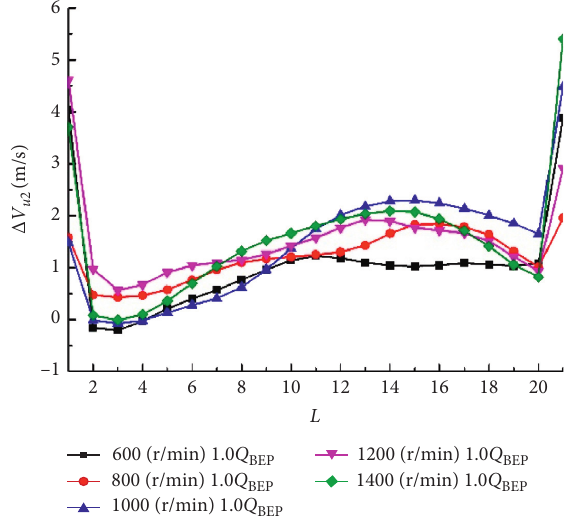
Figure 14: Slip velocity at different speeds.